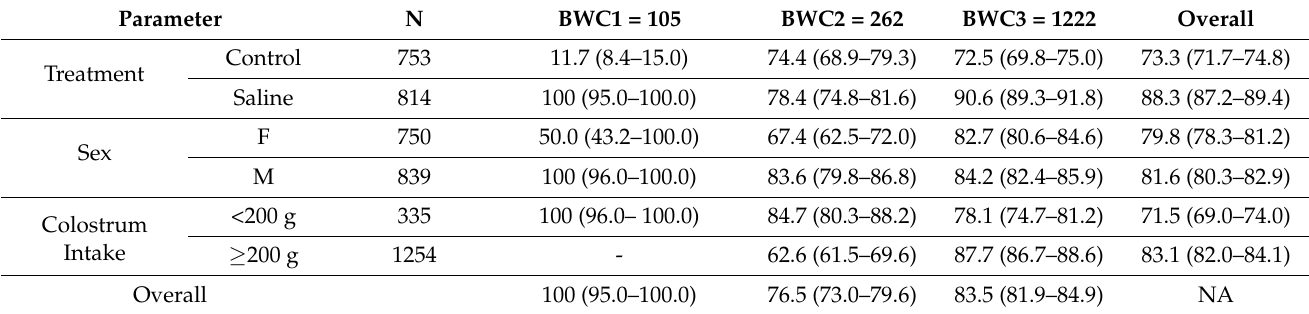
Table 3. Percentages and respective 95% confidence intervals of survival rates from day 1 (24 h) to 20 days for 1589 piglet observations after bootstrapping at a root of 24. Body weight category: BWC = 1; ≤ 0.80 kg, BWC = 2; 0.81 kg to 1.10 kg, and BWC = 3; >1.10 kg. Saline =